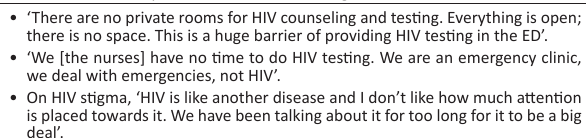
FIGURE 2: A graphical representation of key provider attitudes towards emergency department-based HIV testing on a Likert scale. BOX 2: Quotes from providers collected during